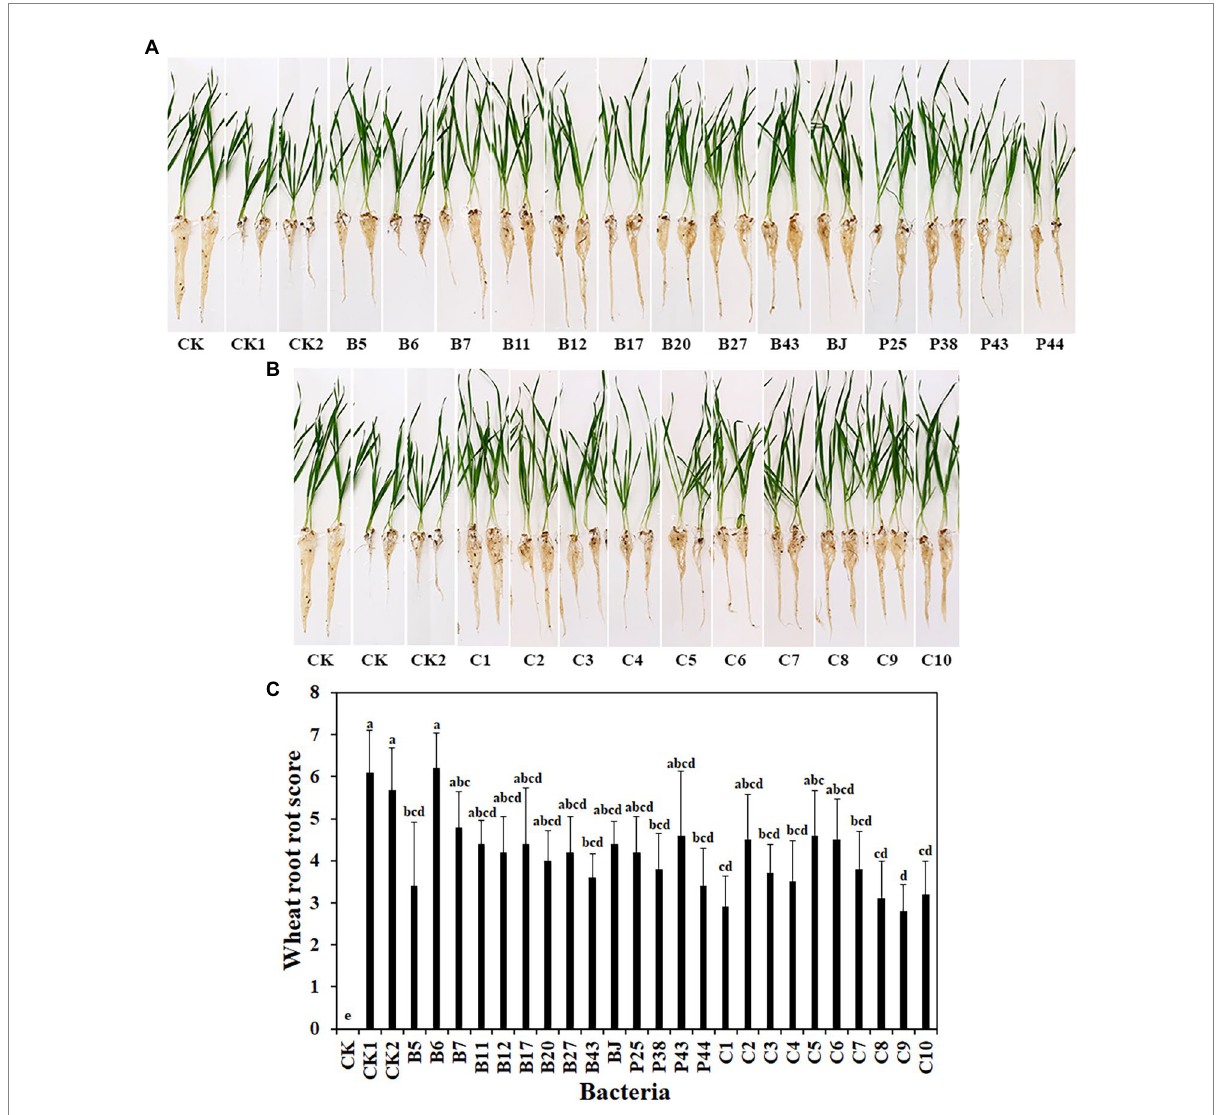
FIGURE 2 Effects of bacteria on wheat root rot caused by R. solani AG8. (A) . Single bacterial strain. (B) . SynComs. (C) . Wheat root rot scores. CK: Wheat grown in soil without bacteria and AG8 inoculation; CK1: AG8 only; CK2: AG8 and ddH 2 O; B5: AG8 and Pseudomonas sp. B5; B6: AG8 and Streptomyces sp. B6; B7: AG8 and Chryseobacterium sp. B7; B11: AG8 and Pseudomonas sp. B11; B12: AG8 and Pseudomonas sp. B12; B17: AG8 and Sphingomonas sp. B17; B20: AG8 and Cupriavidus campinensis B20; B27: AG8 and Asticcacaulis sp. B27; B43: AG8 and Rhodococcus erythropolis B43; BJ: AG8 and Janthinobacterium lividum BJ; P25: AG8 and Pseudomonas sp. P25; P38: AG8 and Chryseobacterium soldanellicola P38; P43: AG8 and Chryseobacterium sp. P43; P44: AG8 and Pedobacter sp. P44; C1: AG8 and SynCom 1; C2: AG8 and SynCom 2; C3: AG8 and SynCom 3; C4: AG8 and SynCom 4; C5: AG8 and SynCom 5; C6: AG8 and SynCom 6; C7: AG8 and SynCom 7; C8: AG8 and SynCom 8; C9: AG8 and SynCom 9; C10: AG8 and SynCom 10. The values are means ± SD. Different letters indicate significant